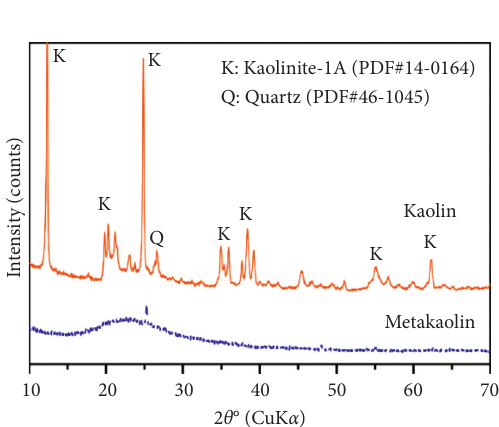
Figure 3: XRD pattern of kaolin and metakaolin.